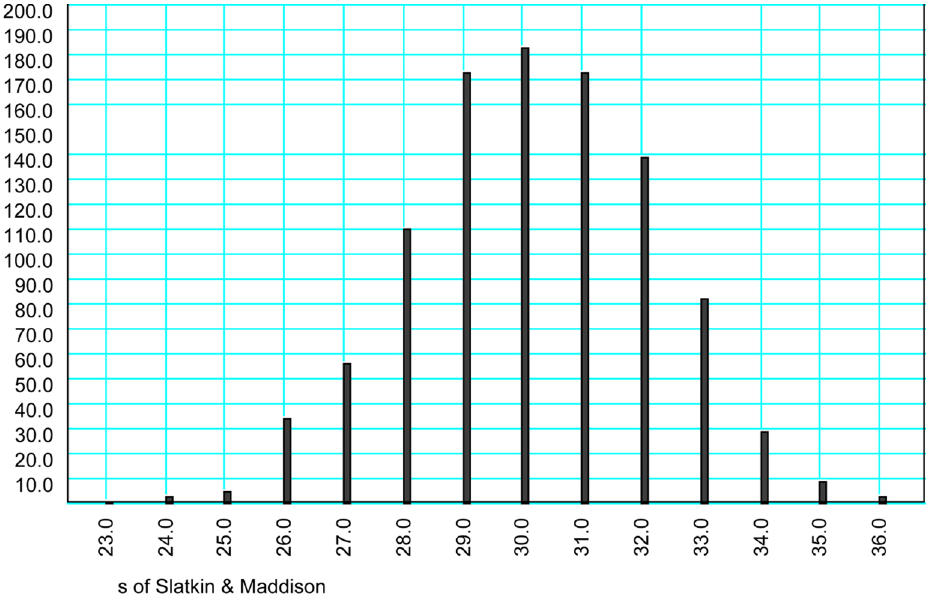
Figure 4. Distribution of s -values from simulated genealogies constrained within the models of population divergence. Single- refugium hypothesis.